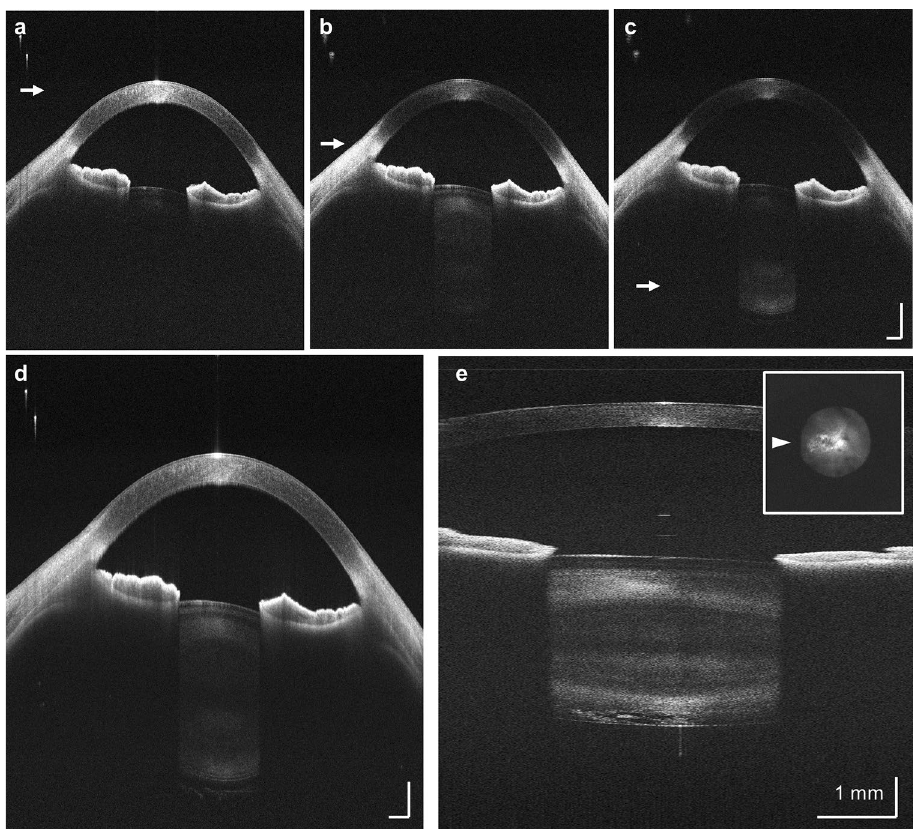
Figure 5. SS-OCT imaging of the full anterior segment of the eye. ( a )–( c ) Extracted 20-mm B-scans where the focal depth position is dynamically adjusted with 18 steps at ~ 500 µm spacing. The focal plane shifts from the cornea to the posterior surface of the lens capsule. White arrow: corresponding location of the focal plane. ( d ) Fused full depth high resolution cross-sectional image using all focally stepped B-scans. ( e ) 6-mm OCT volume of an eye with subcapsular cataract. The focal plane is fixed at the posterior lens capsule. The B-scan corresponds to the horizontal meridian (white arrowhead). Insert: en face OCT amplitude projection along the depth